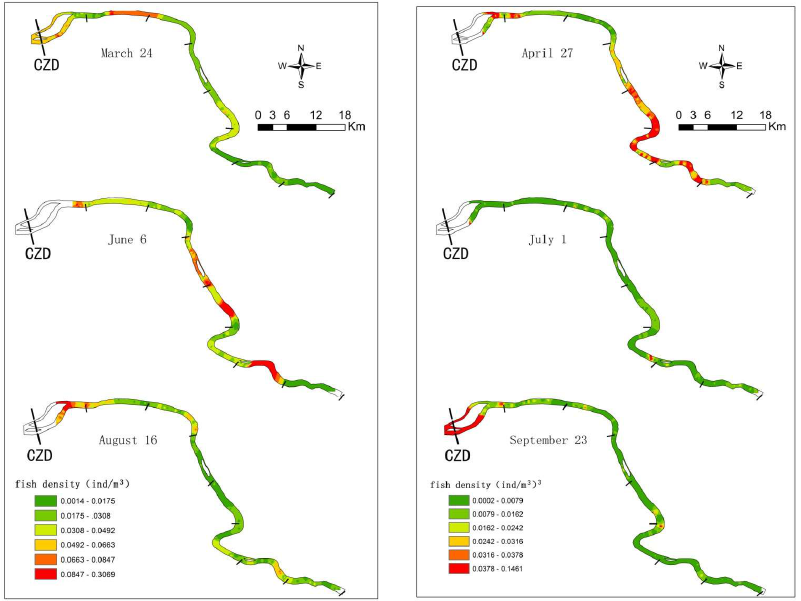
Commented [M16]: Please cite the figure in the appears in numerical order.